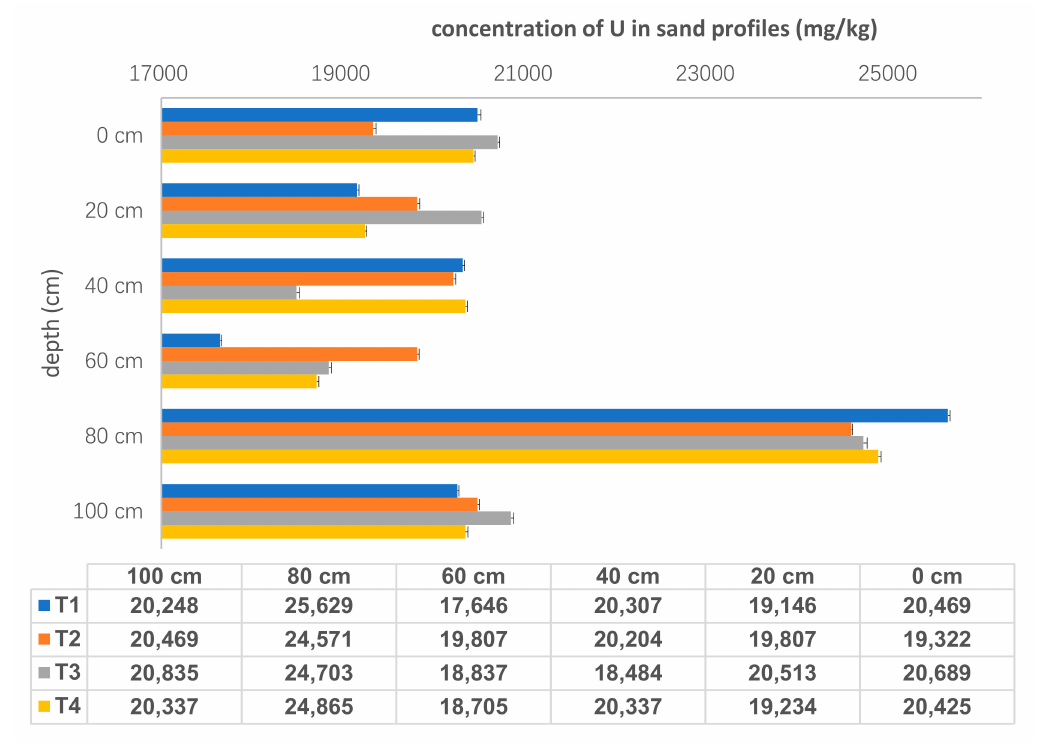
Figure 3. The concentrations of U in sand samples ( n = 24).